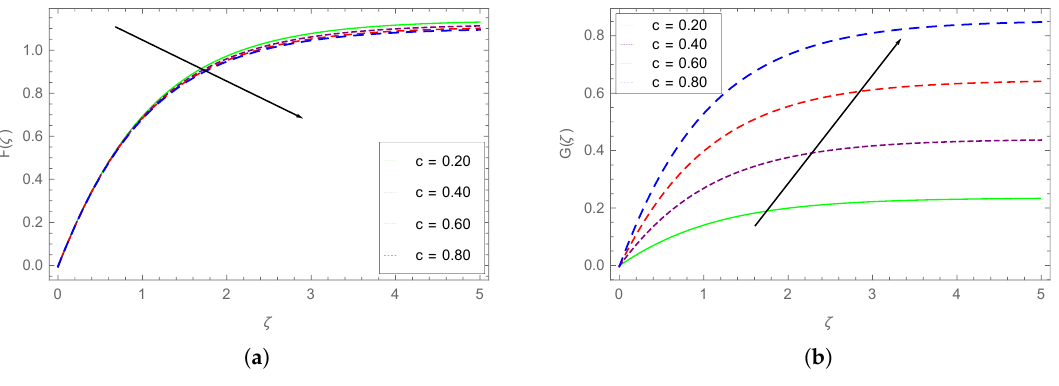
Figure 3. ( a ) Impact of c on F ( ζ ) and ( b ) G ( ζ ) .